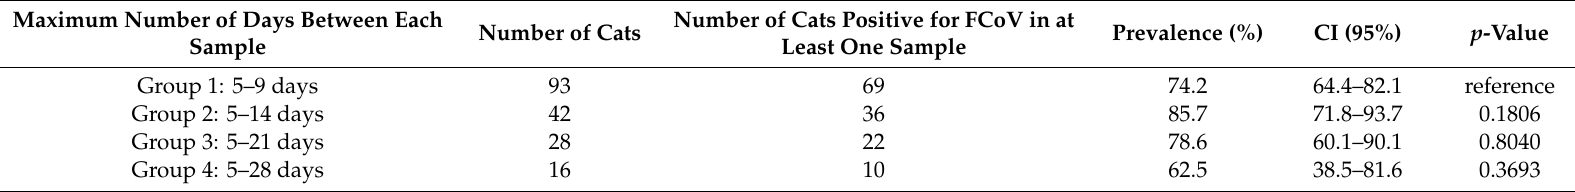
Table 3. Cats were divided into four groups according to the longest of the time intervals between the collection of their four fecal samples: Group 1 included cats for which all time intervals were 5–9 days; Group 2 included cats for which the longest time interval was 10–14 days; Group 3 included cats for which the longest time interval was 15–21 days; Group 4 included cats for which the longest time interval was 22–28 days. Prevalence of feline coronavirus (FCoV) shedding was calculated separately for each group. A cat was considered a FCoV shedder when at least one of the four samples tested positive for FCoV. Groups 2, 3, and 4 were compared to the reference group 1 using Fisher’s exact